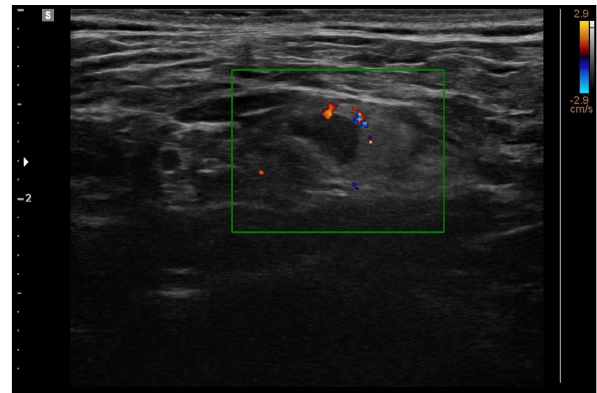
Fig. 6. Metastatic lymph node with cortex thickening and perifo- cal edema (verified by